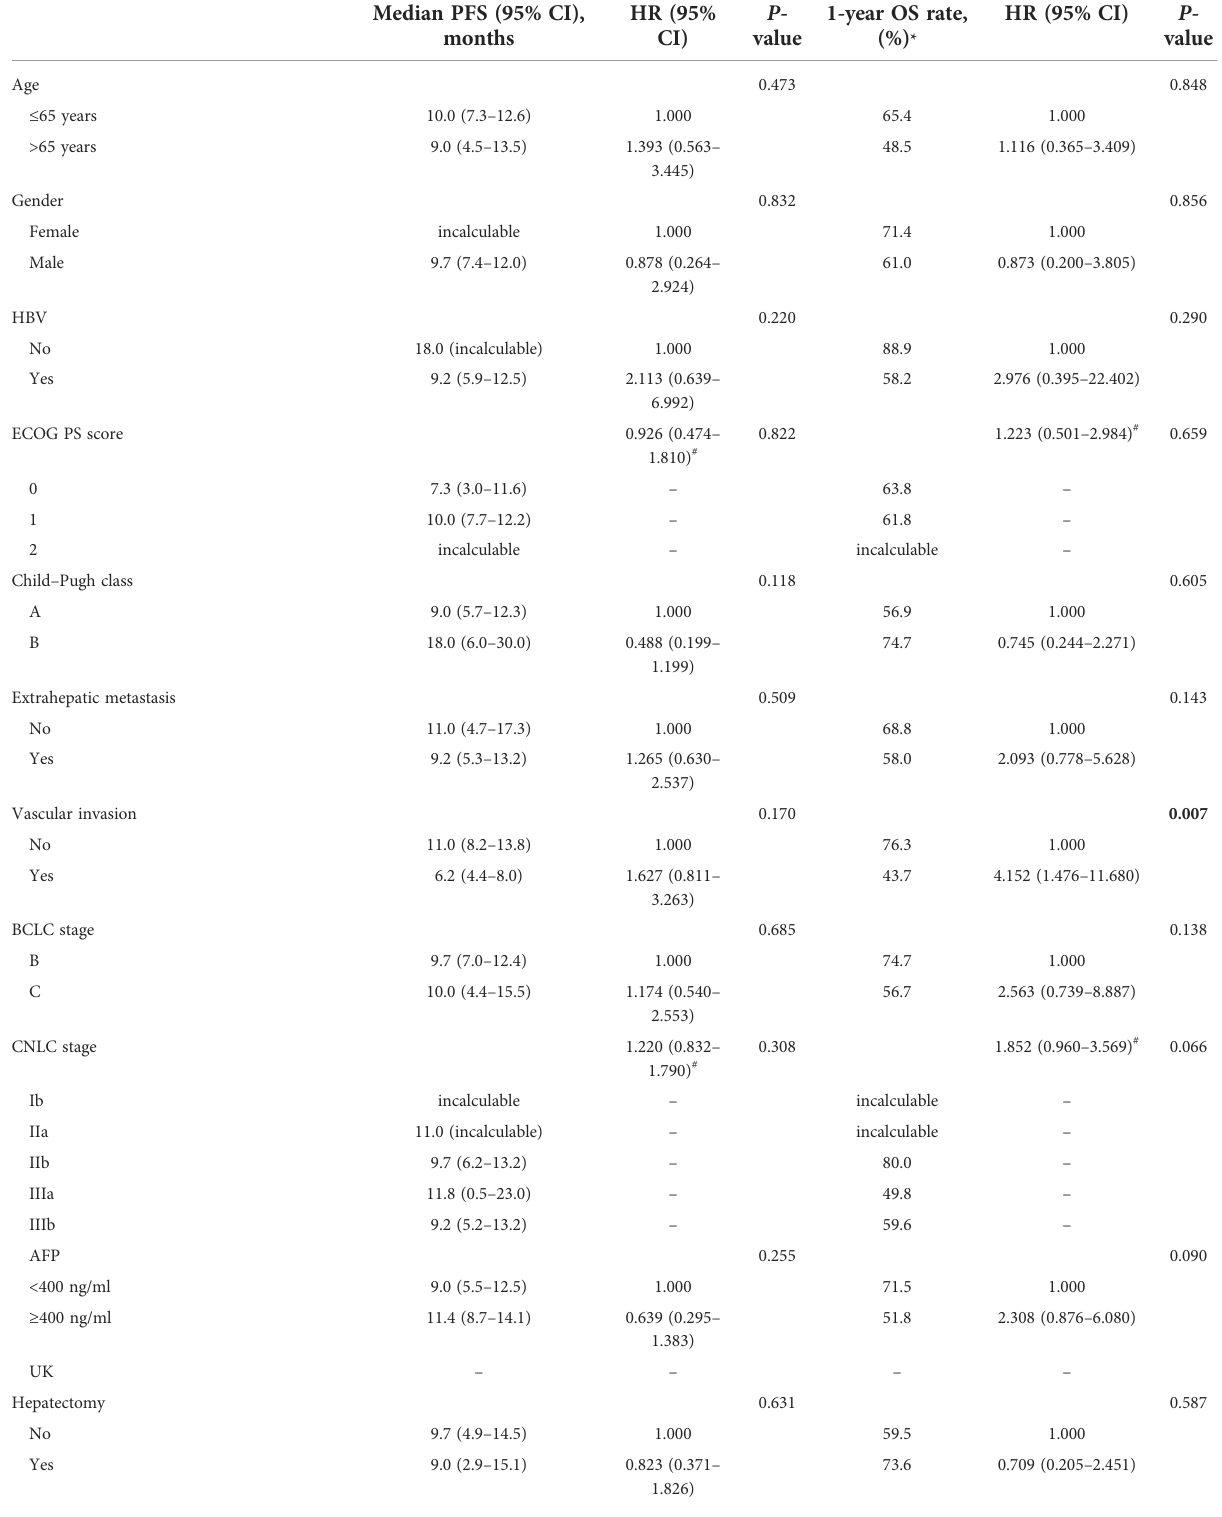
TABLE 3 Subgroup analysis of PFS and